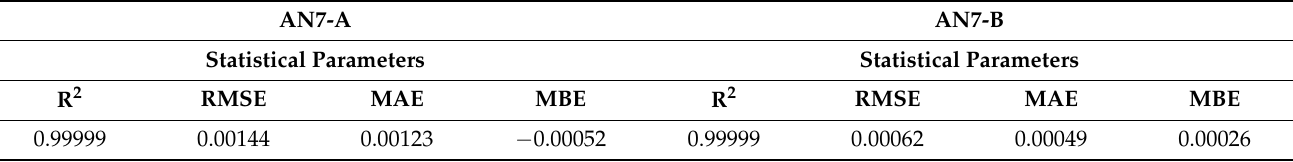
( i ) ( ii ) Figure 7. Error histogram of simulated data for ( i ) AN7-A, ( ii ) AN7-B. 4. Conclusions Thermal cracking of polymers, consisting of PS, LDPE, and PP, was implemented using TGA at heating rate range (5–40 K/min), with two groups of sets: (ratio 1:1) a mixture of PS and PP, and (ratio 1:1:1) a mixture of PS, LDPE, and PP. TGA data are used in modeling ANN for two sets of PS, LDPE, and PP polymers in order to predict the weight left %.